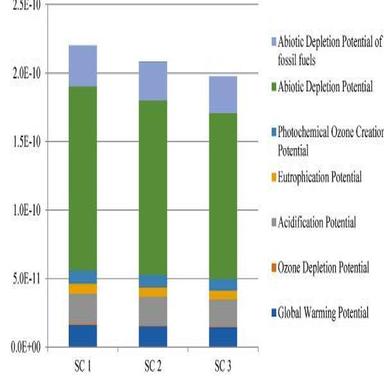
Normalisation of PLA and PLA/OW impact contribution to total environmental impacts (CML-IA baseline V3.07/EU25+3).